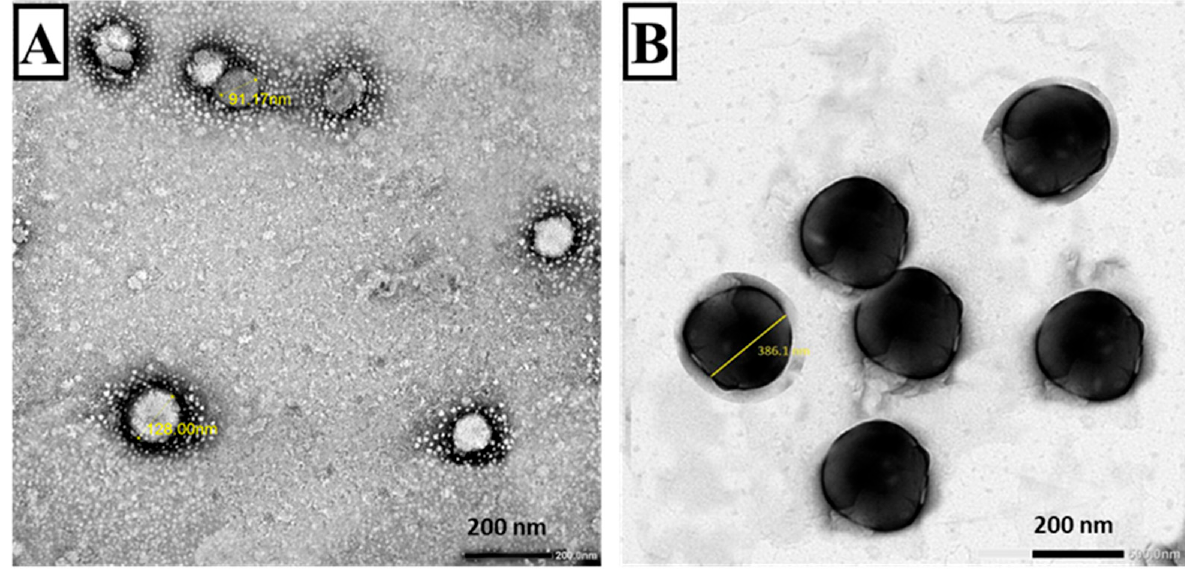
Figure 3. TEM of plain and adjuvant loaded SLNs ( × 30,000). ( A ) Plain SLNs showing rounded smooth surfaces with sizes ranging from 83.87–106.81 nm. ( B ) MLT-SLNs rounded smooth surfaces with sizes ranging from 278.12–330.4 nm.